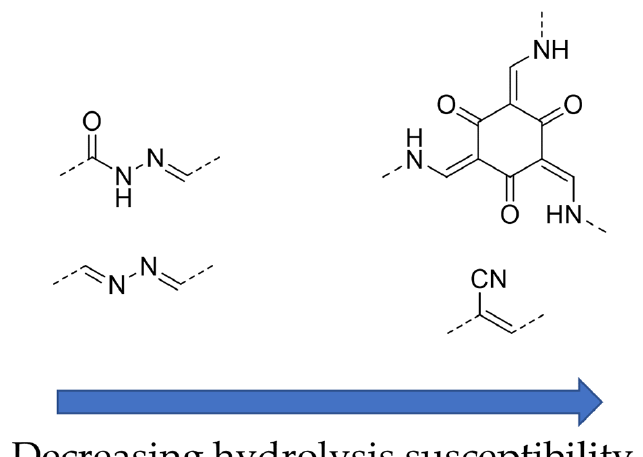
Figure 33. Structures of the linkers reported for COF materials active for photocatalytic hydrogen evolution with arranged according to their relative hydrolysis susceptibility. Table 2. Comparison of photocatalytic activity associated involving materials with relatively large internal surface area.